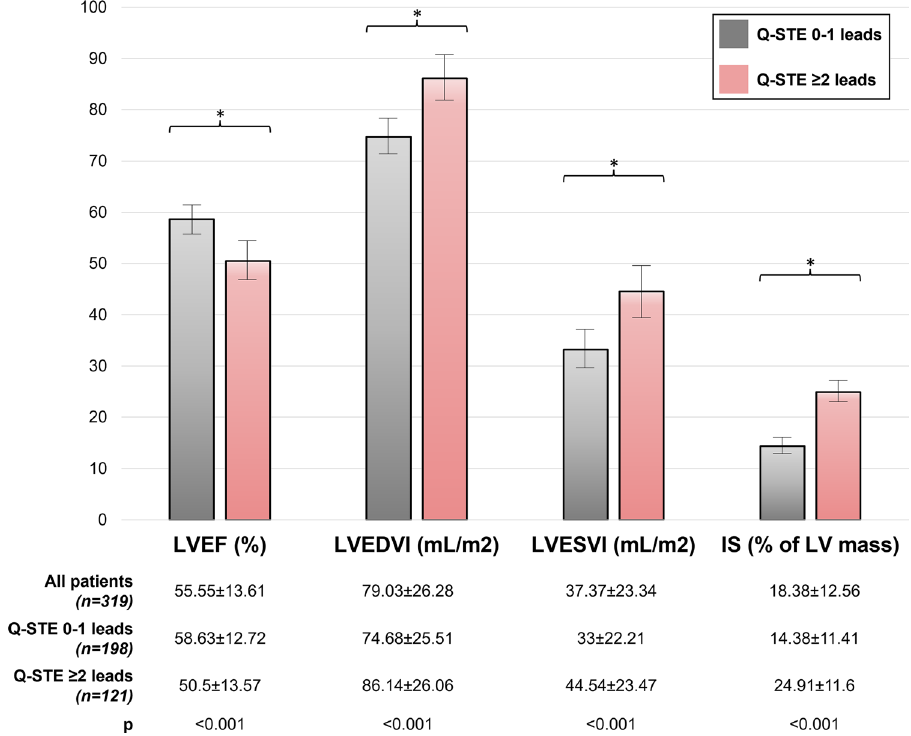
Figure 2. Structural changes at 6-month CMR according to Q-STE category. Variables are presented as mean ± standard deviation. * = p < 0.001. Abbreviations: CMR = cardiac magnetic resonance. IS = infarct size. LVEF = left ventricular ejection fraction. LVEDVI = left ventricular end-diastolic volume index. LVESVI = left ventricular end-systolic volume index. Q-STE = Q wave and residual STE > 1